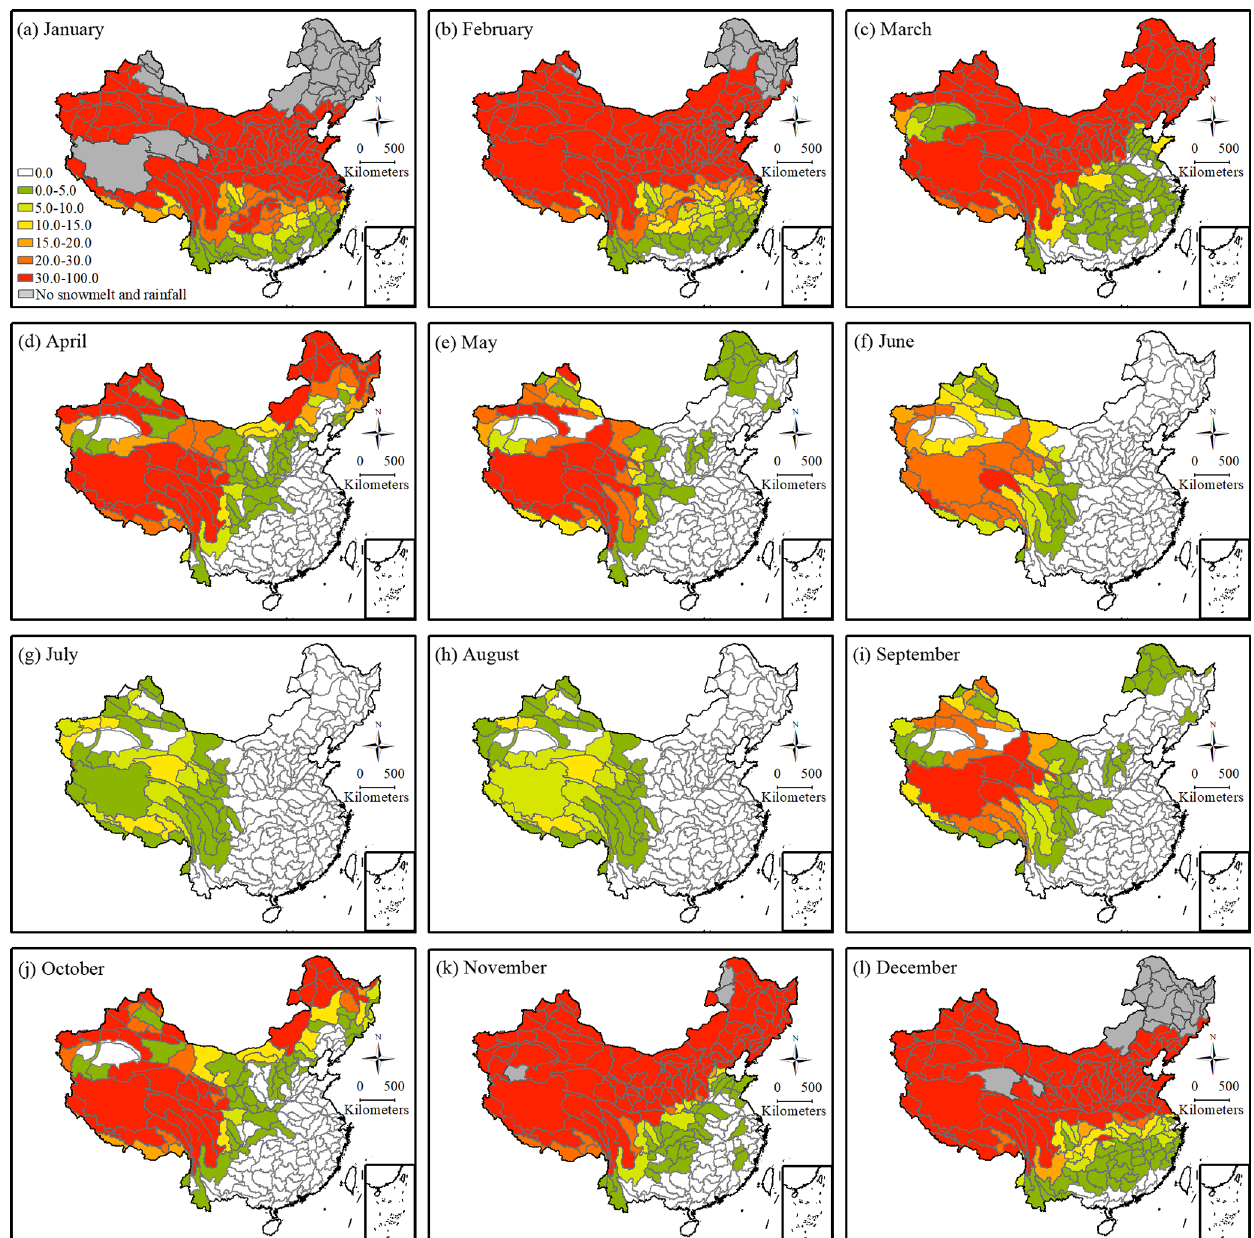
Figure 11. Spatial distribution of the monthly mean snowmelt runoff ratio (percent) for 12 months in the third-level basins in China during the 1951–2017